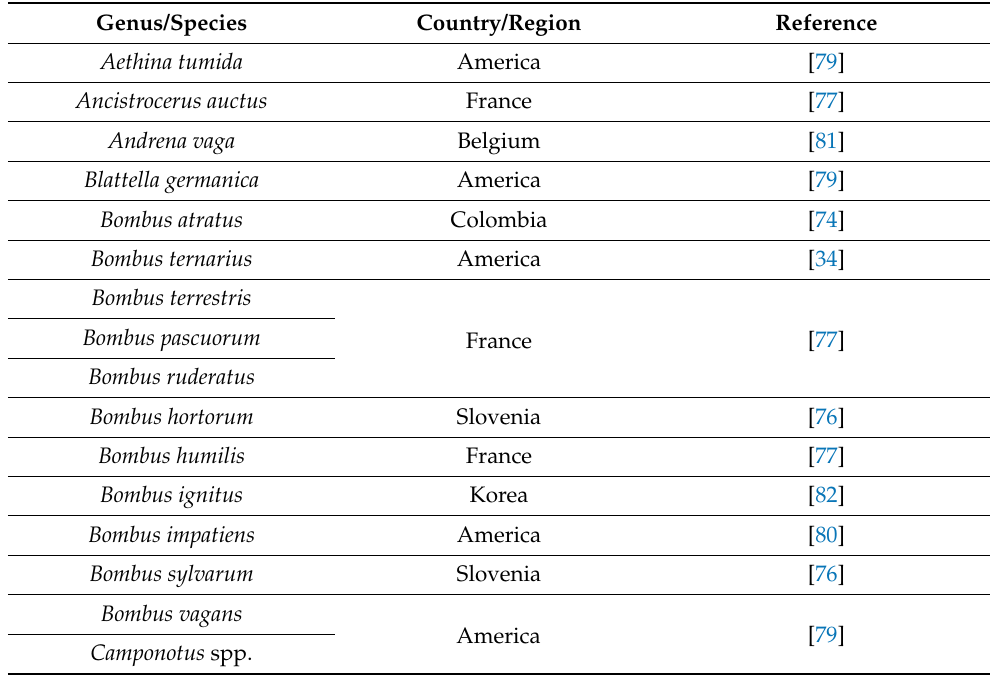
Table 1. Non- Apis hymenopteran pollinators that were detected positively with